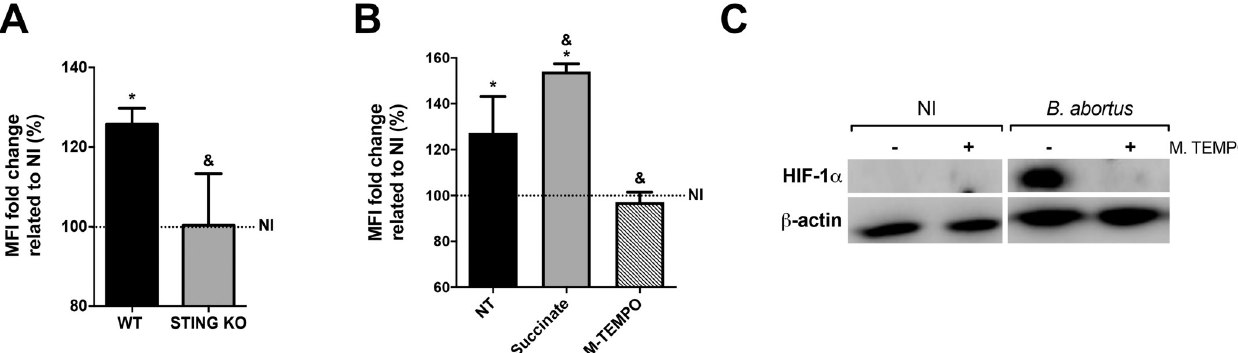
Fig 6. STING drives mROS production which augments HIF-1 α stabilization. (A) MitoSOX Red flow cytometry analysis of mROS generation in B . abortus -infected macrophages derived from C57BL/6 (WT) and STING KO mice. (B) MitoSOX Red flow cytometry analysis of mROS generation in B . abortus -infected macrophages derived from C57BL/6 (WT) pretreated with succinate (5 mM), Mito-TEMPO (M.TEMPO, 0.5 mM) or vehicle (non-treated, NT). (C) Western blot analysis of HIF-1 α in cell lysates from macrophages derived from C57BL/6 (WT) pretreated or not with Mito-TEMPO (M.TEMPO, 0.5 mM) and then non-infected (NI) or infected with B . abortus . Equal loading was controlled by measuring β -actin in the corresponding cell lysates. The data (A-C) are representative of three independent experiments. The data (A) is presented as mean ± SD, & (comparison between WT and KO) or � [comparison between non-infected (NI, set to 100%) and infected], p < 0.05, one-way ANOVA. The data (B) is presented as mean ± SD, & (comparison between NT and treated) or � [comparison between non-infected (NI, set to 100%) and infected], p < 0.05, one-way